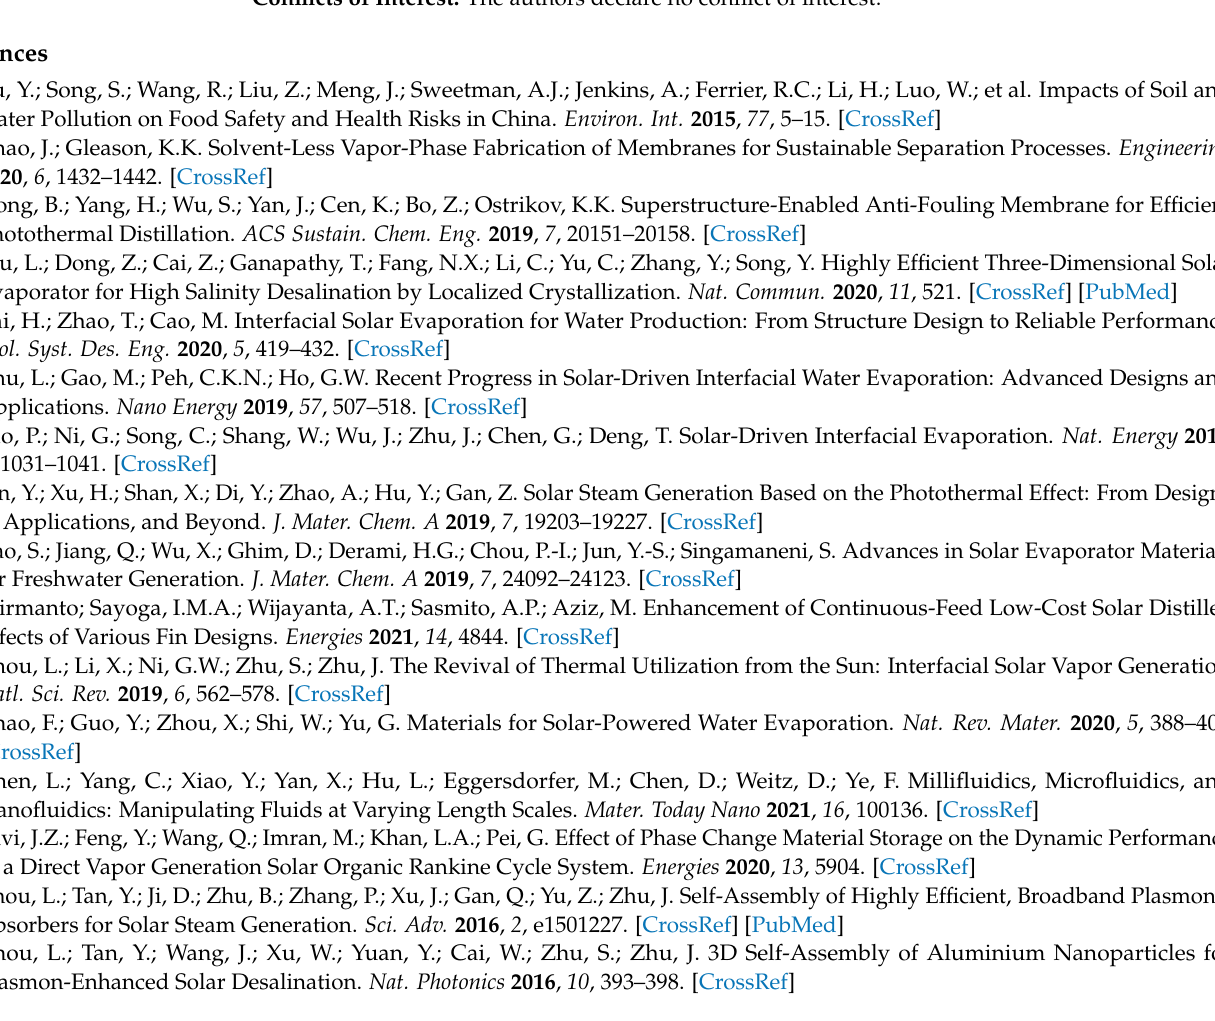
samples. Table S4: Performances of water evaporation using APEG-TPE samples with different porosity. Figure S1: Schematic illustration of the hydrolysis of t -BA. Figure S2: Water evaporation in dark from neat air/water interface or using APEG-TPEs as control groups. Figure S3: Optical images of APEG-TPEs with different